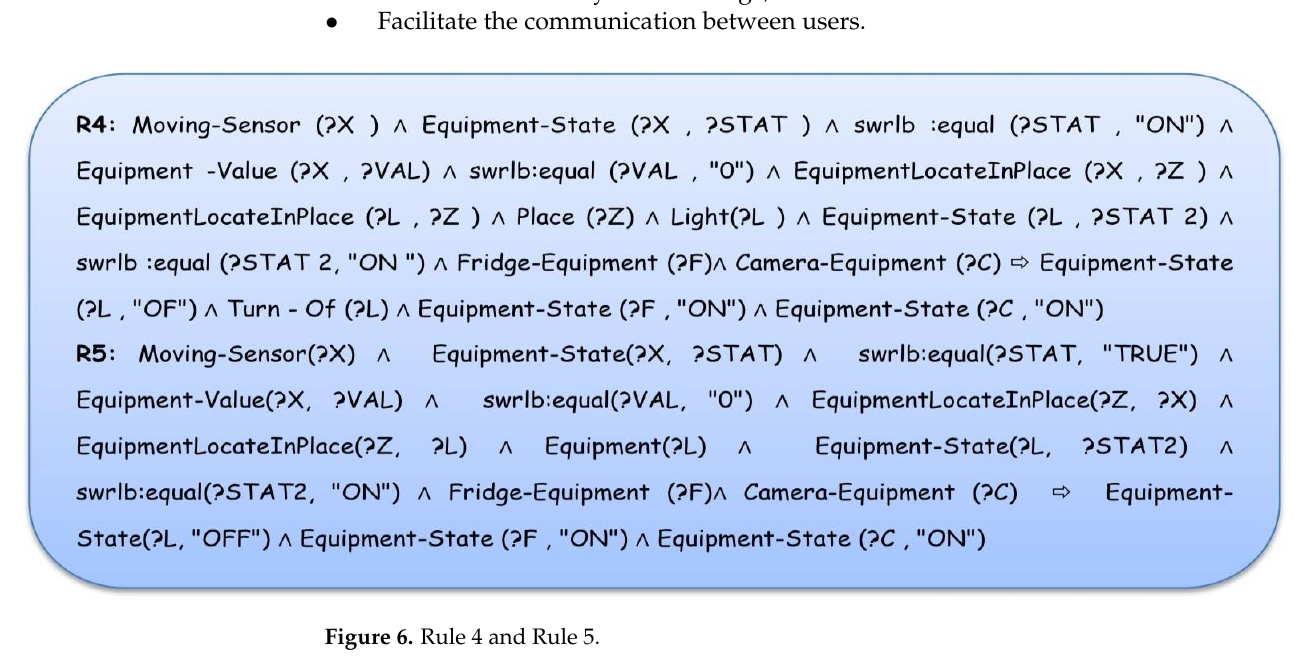
Figure 6. Rule 4 and Rule 5.